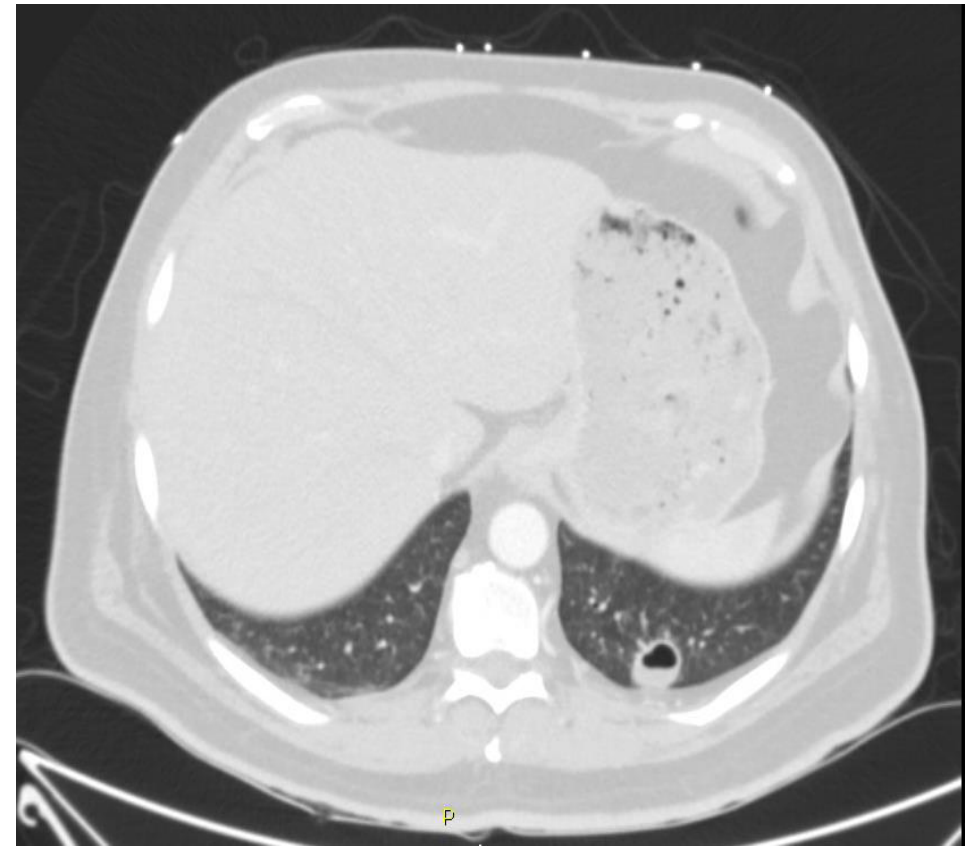
Figure 1. Computerized tomograph of the chest showing a 1.7 × 2 × 1.9 cm cavitary lesion with layering internal fluid within the posterior left lower lobe. There was an additional smaller cavitary lesion within the right upper lobe measuring 5 mm and a 1 cm ground glass nodule in the left lower lobe.